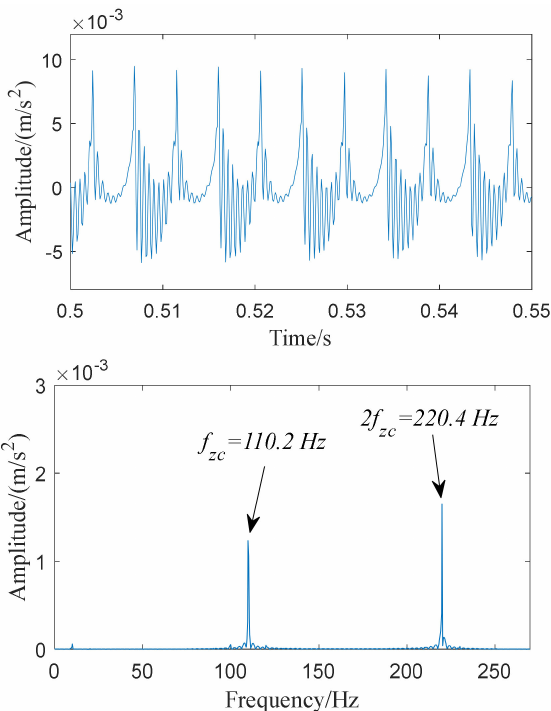
Figure 11. Time–domain signal and envelope spectrum of the normal state (numerical simulation).